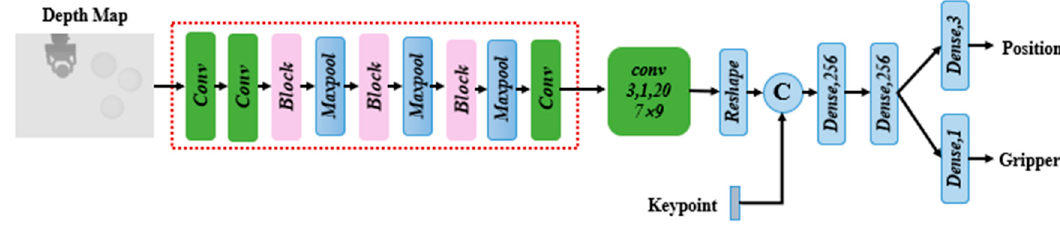
Figure 4. The structure of the motion policy network.